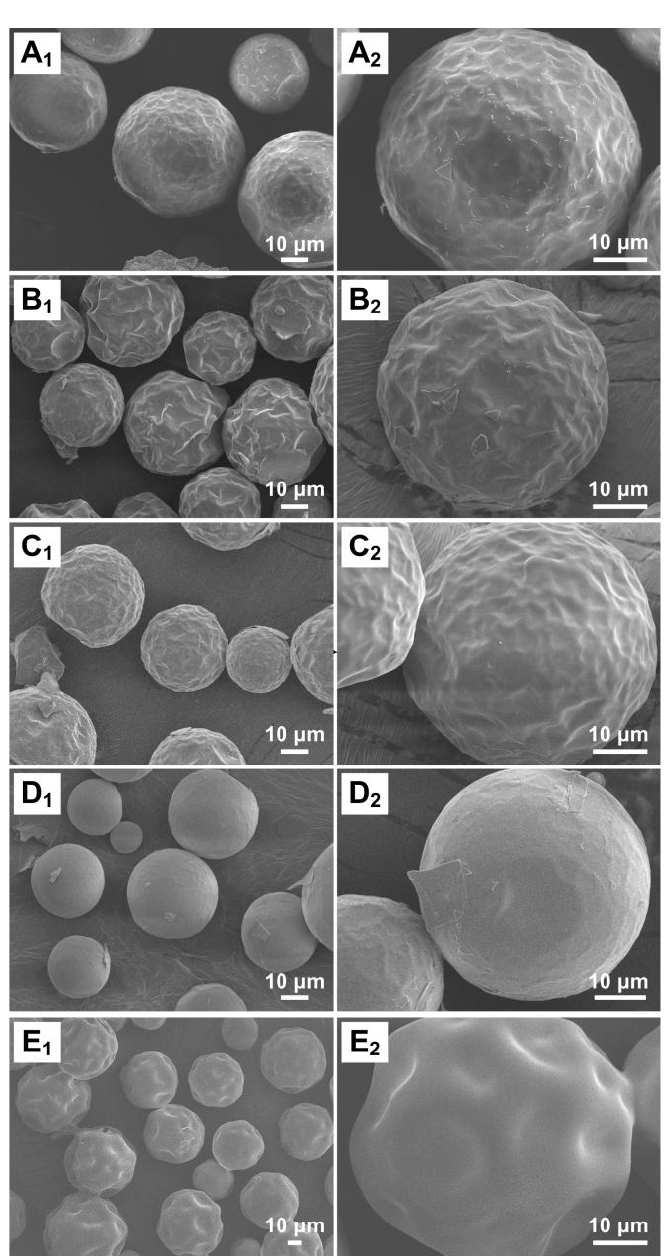
Figure 3. Scanning electron microscopy images of spray-dried microcapsules: ( A 1 ) and ( A 2 ): F1, ( B 1 ) and ( B 2 ): F4, ( C 1 ) and ( C 2 ): F5, ( D 1 ) and ( D 2 ): F6, and ( E 1 ) and ( E 2 ): F7.